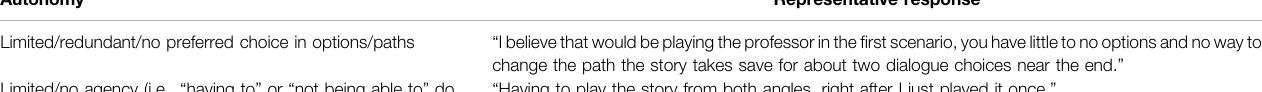
TABLE 2 | Rubric used for scoring qualitative answers (left column) and corresponding “ LEAST enjoy ” representative responses from study participants (right). Autonomy